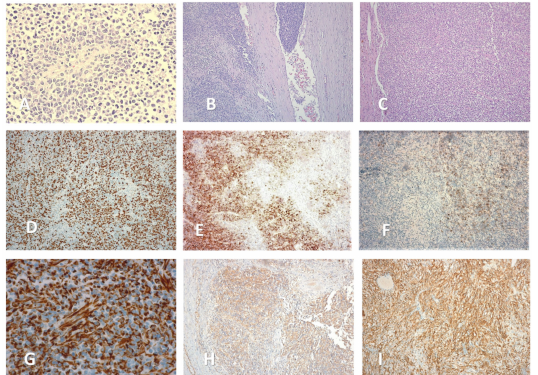
Figure 4. Microscopic aspects of the adrenal mass (magnification size). ( A ) Rosette-like arrangement of tumoral cells, around a blood vessel ( × 40). ( B ) Venous tumoral emboli ( × 10). ( C ) Hematoxylin— eosin stain ( × 10). ( D ) Ki—67 stain ( × 20). ( E ) Positive CD 10 stain (parcelar pattern) ( × 10). ( F )